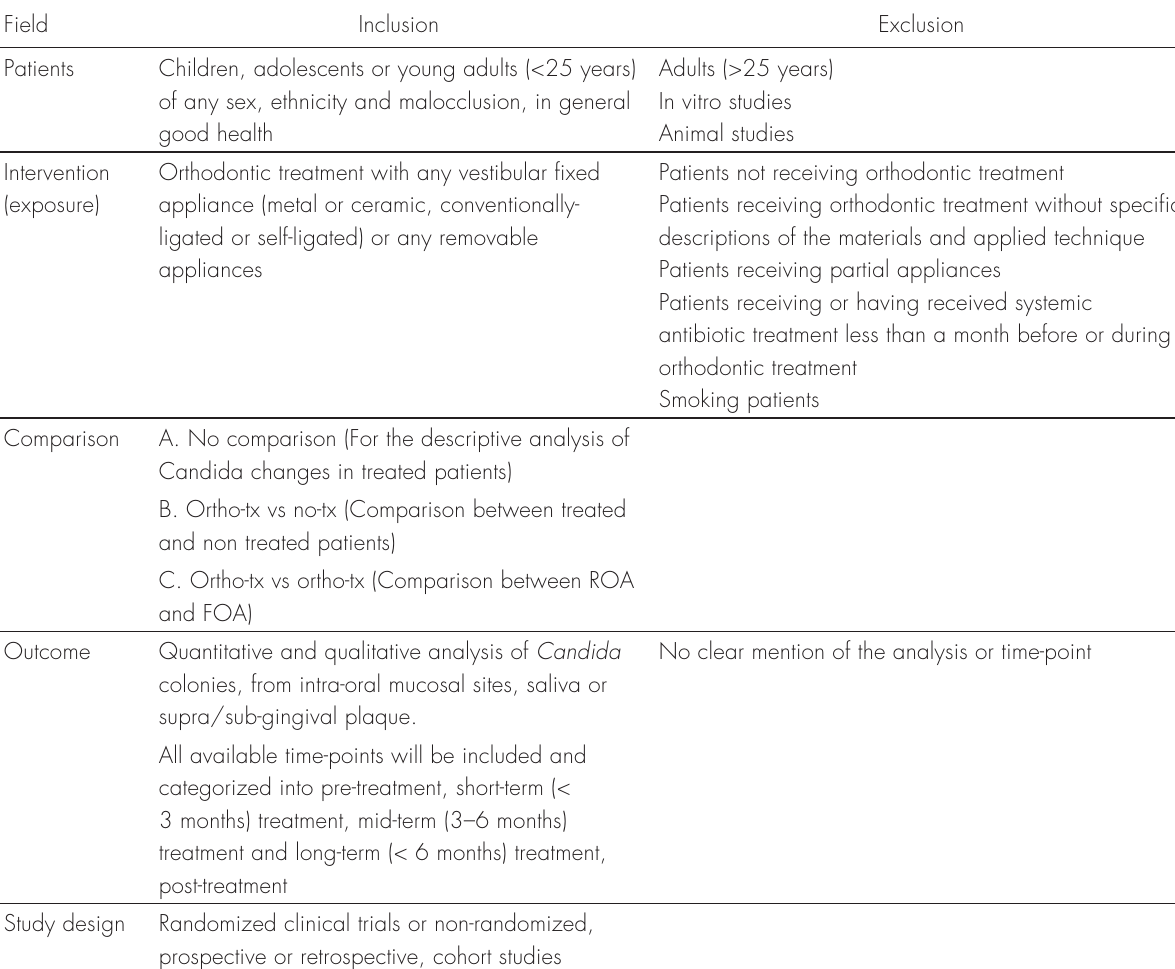
Table I. List of inclusion and exclusion criteria.